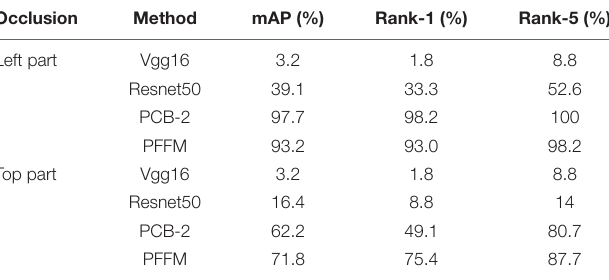
TABLE 5 | The performance of Vgg16, Resnet50, PCB-2, and pyramidal feature fusion model (PFFM) on crab-back-211, where PCB-2 represents that feature is divided into 2 horizontal blocks using